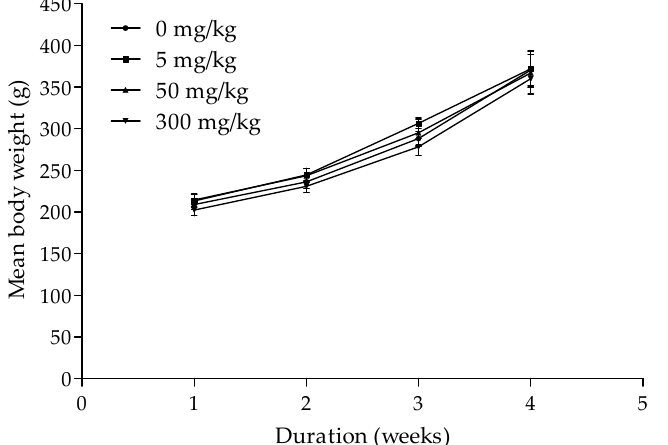
Figure 2. Mean body weight (g) of rats treated with varying doses of aqueous herbal extract weekly over a four-week duration. Values are mean (standard error, n = 7).